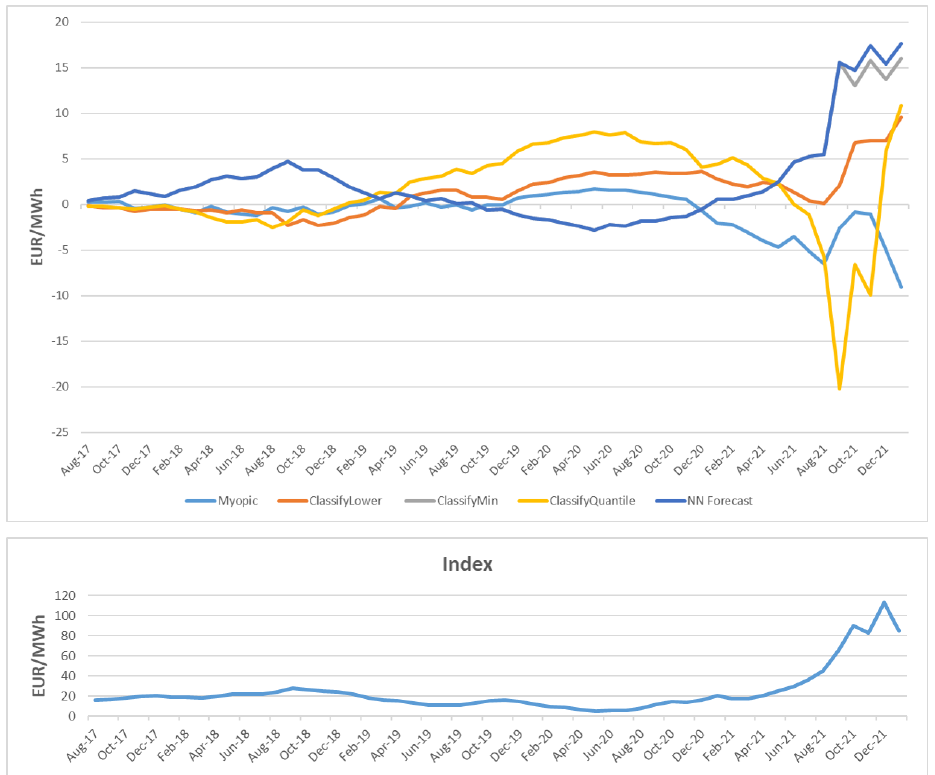
Figure 5. Cumulative Payoff of All